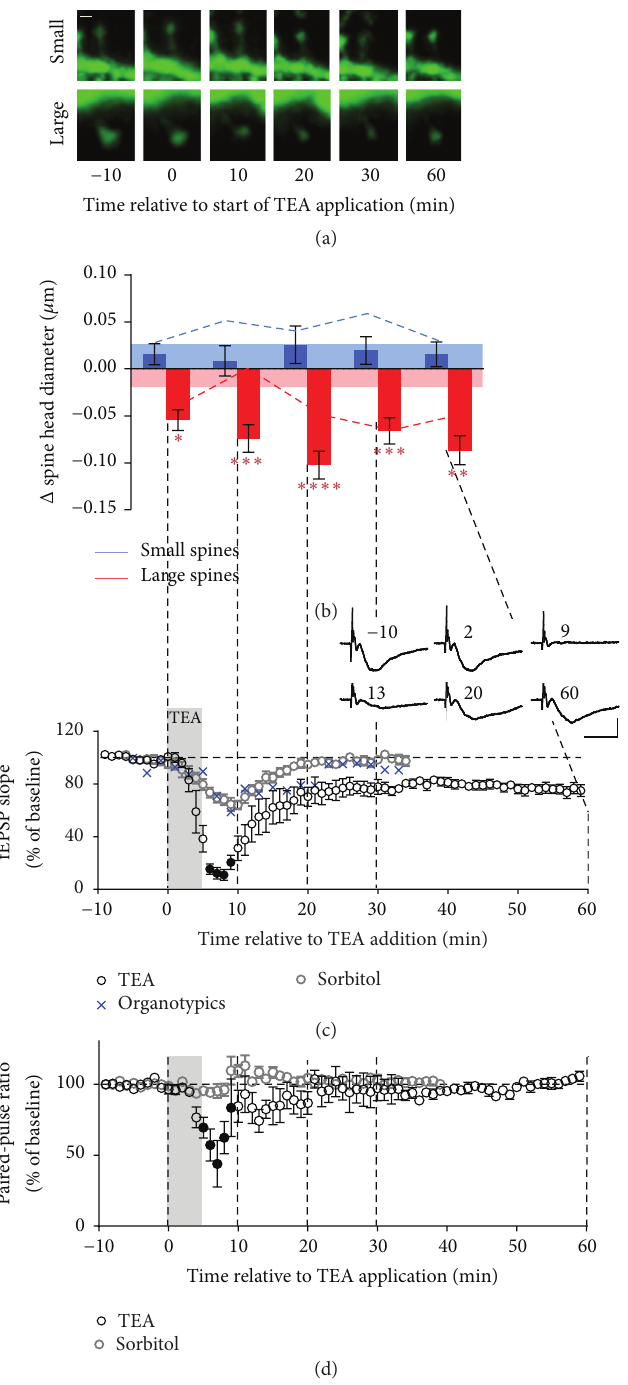
Figure 3: Synapses in DG granule cells behave differently from CA1 synapses in response to the same TEA stimulus. (a) Typical example of a small and a large spine imaged before ( − 10), during (0), and after washout (10–60 min) of TEA (25 mM, 5 min). Scale bar: 0.5 𝜇 m. (b) Quantification of changes in spine size. Small spines, blue; large spines, red. Limits of the shading represent the mean change across time in the absence of TEA (time course control experiments). Post hoc analysis of control data versus TEA (3-way interaction between size, time, and treatment): ∗ 𝑝 < 0.05 ; ∗∗ 𝑝 < 0.01 ; ∗∗∗ 𝑝 < 0.001 ; ∗∗∗∗ 𝑝 < 0.0001 . ((c), (d)) Slope and PPR of fEPSP recorded in the DG granule cells region in organotypic and acute hippocampal slices in response to stimulation of the perforant path, before and after application of TEA (black), as above, and high osmolarity ACSF (grey), as above. Closed symbols represent points where responses were too small for reliable measurement. Grey shading: TEA perfusion. Error bars: SEM. Inset: averages of fEPSPs recorded from a typical slice over 1min at 10s intervals at the time indicated (min). Scale bar: 1mV, 10